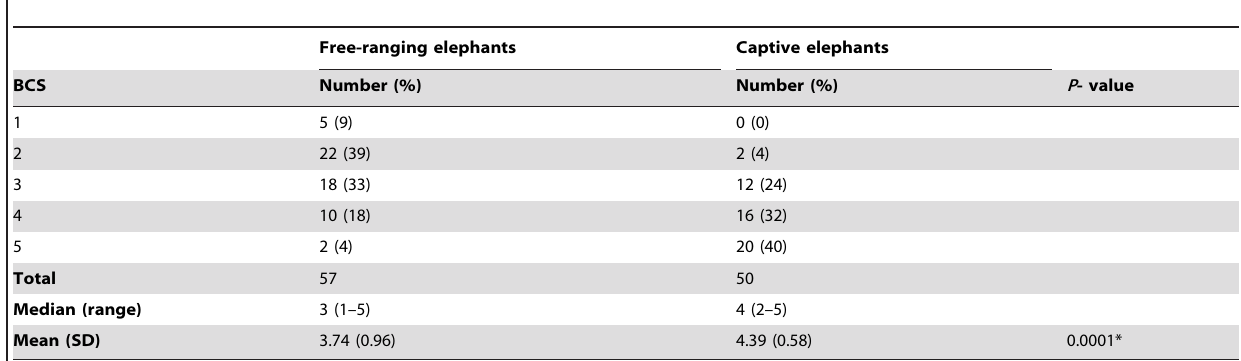
Table 4. Body condition scores (BCS) (and relative percentage) of free-ranging and captive female African elephants in each BCS